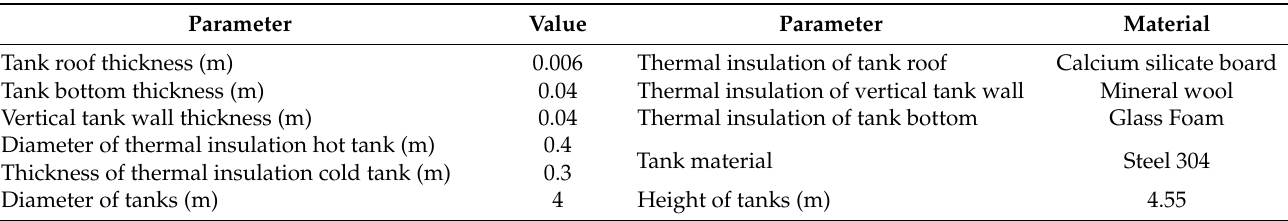
Table 9. Design parameters for storage